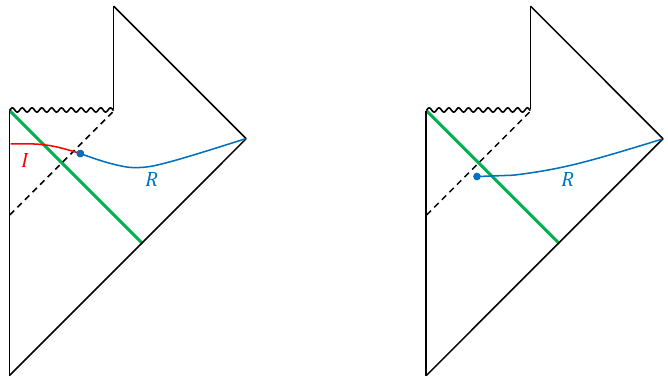
Figure 8 . The Penrose diagram of a black hole formed by a gravitational collapse of a thin null shell. The geometry outside the shell is approximately given by the Schwarzschild geometry, but the interior is the flat spacetime. The region R for b = b c outside the shell is associated with the island I which covers all the other region, and the entanglement entropy is zero (left). If the inner boundary of R is inside the shell, the island would not appear since there is no unstable saddle point in the flat spacetime (right). However, the region R still has the all the information of the initial state, provided that there is no other matter excitations other than the